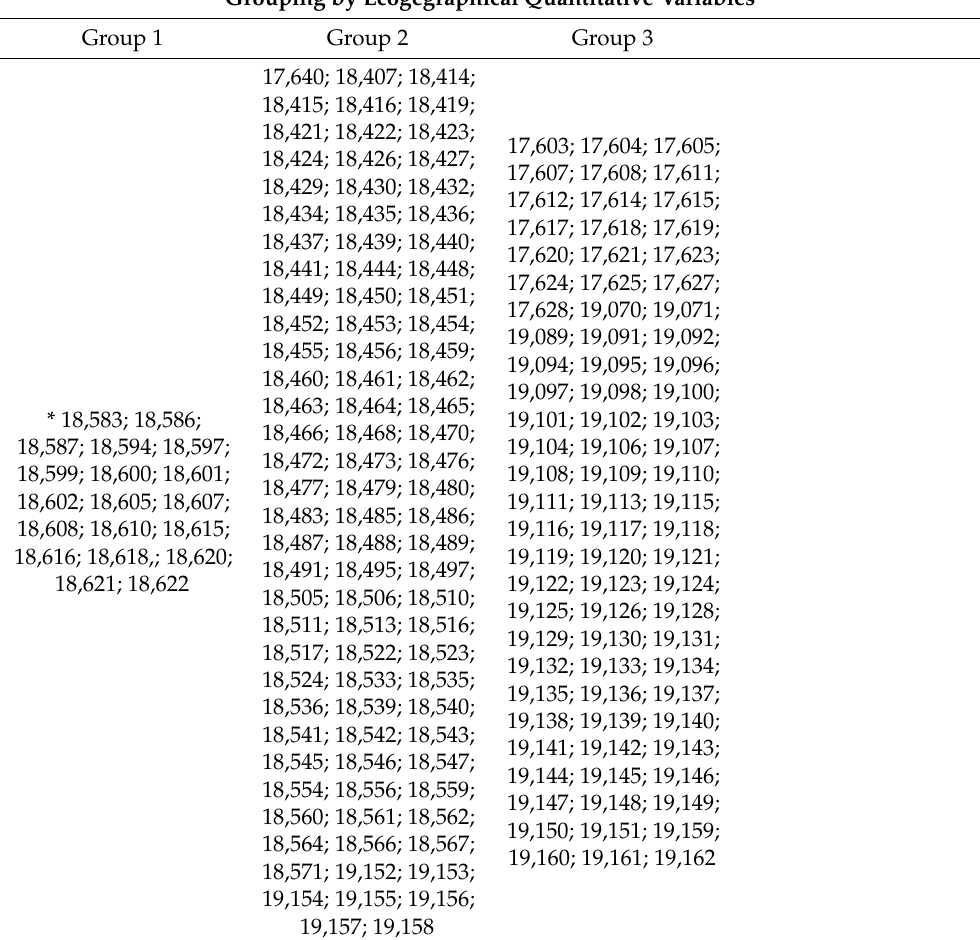
Table A1. Cont. Grouping by Ecogegraphical Quantitative Variables